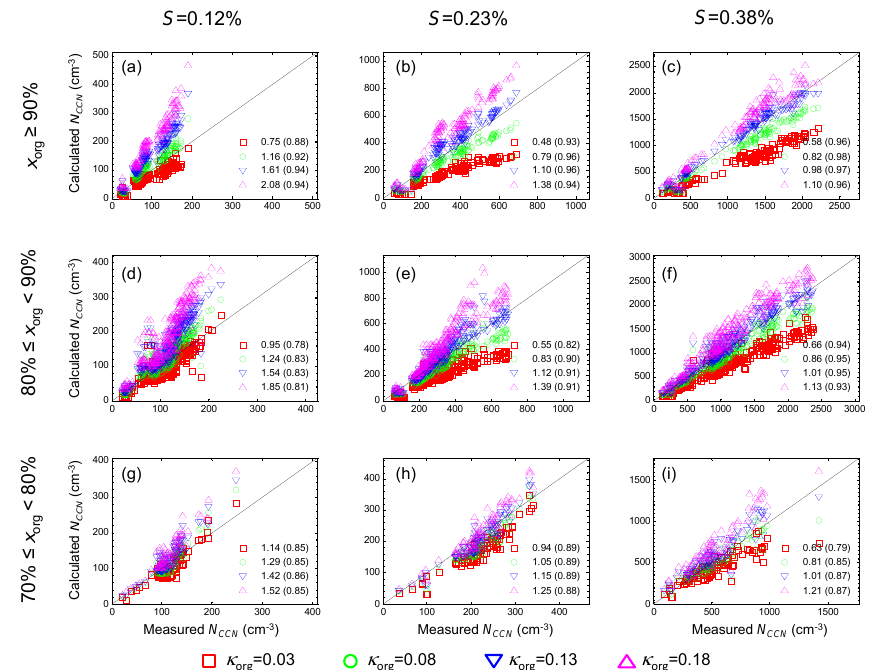
Fig. 3. Comparison of N CCN calculated using four different κ org values and the measurements at supersaturations of 0.12% (a, d, g) , 0.23% (b, e, h) , and 0.38% (c, f, i) for cases when x org >90% (a, b, c) , 80%< x org <90% (d, e, f) , and 70%< x org <80% (g, h, and i) . The slope (left, derived through a bivariate least squares fit) and the R 2 value (in the parenthesis) are shown for all assumed κ org values in each plot. The solid black line corresponds to the 1:1